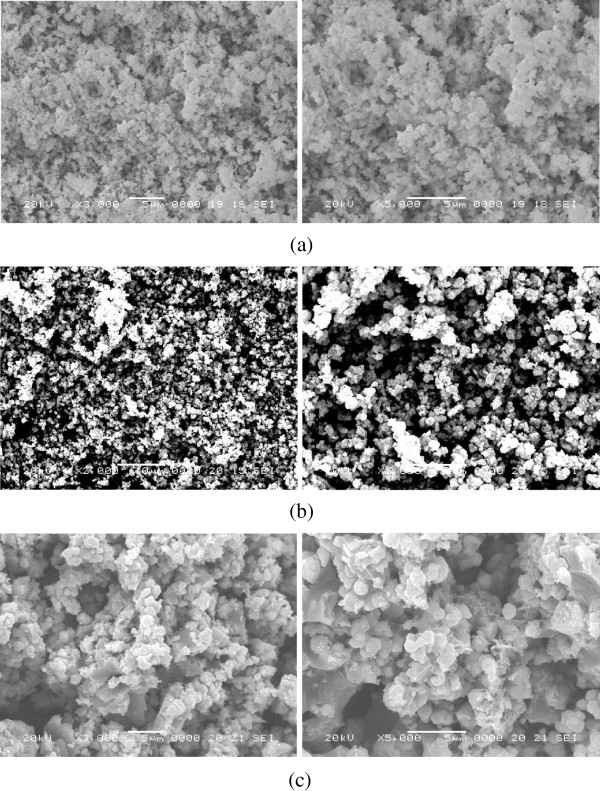
SEM images of CdSe (a), CdSe-TiO2 (b), and CdSe-C60/TiO2 (c), different samples with different magnification.